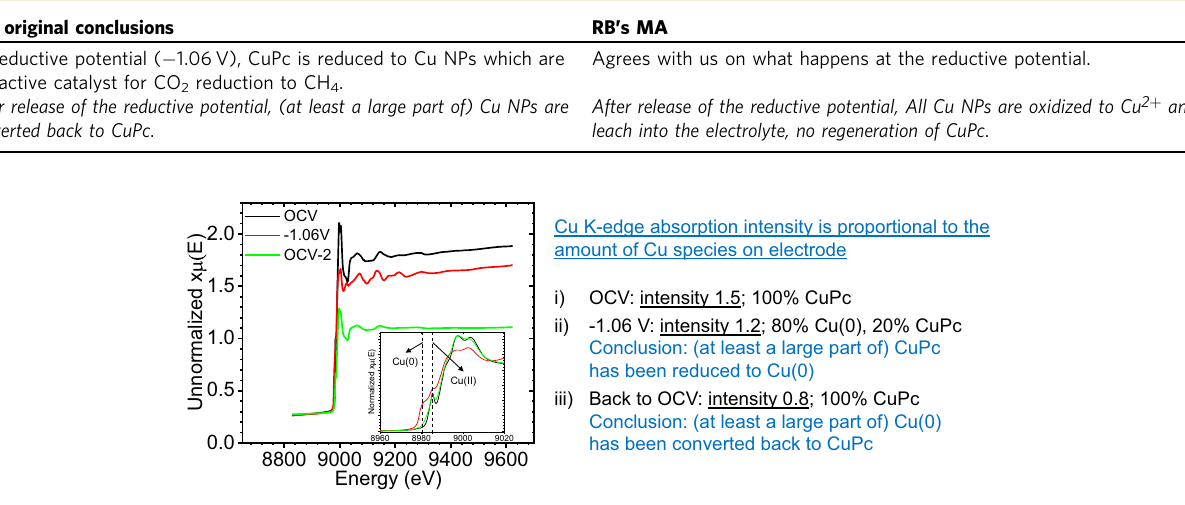
Fig. 1 Unnormalized in-situ XAS spectra. CuPc under electrochemical CO 2 reduction conditions with the near edge structure shown as inset (same original data that generated Fig. 2 in the